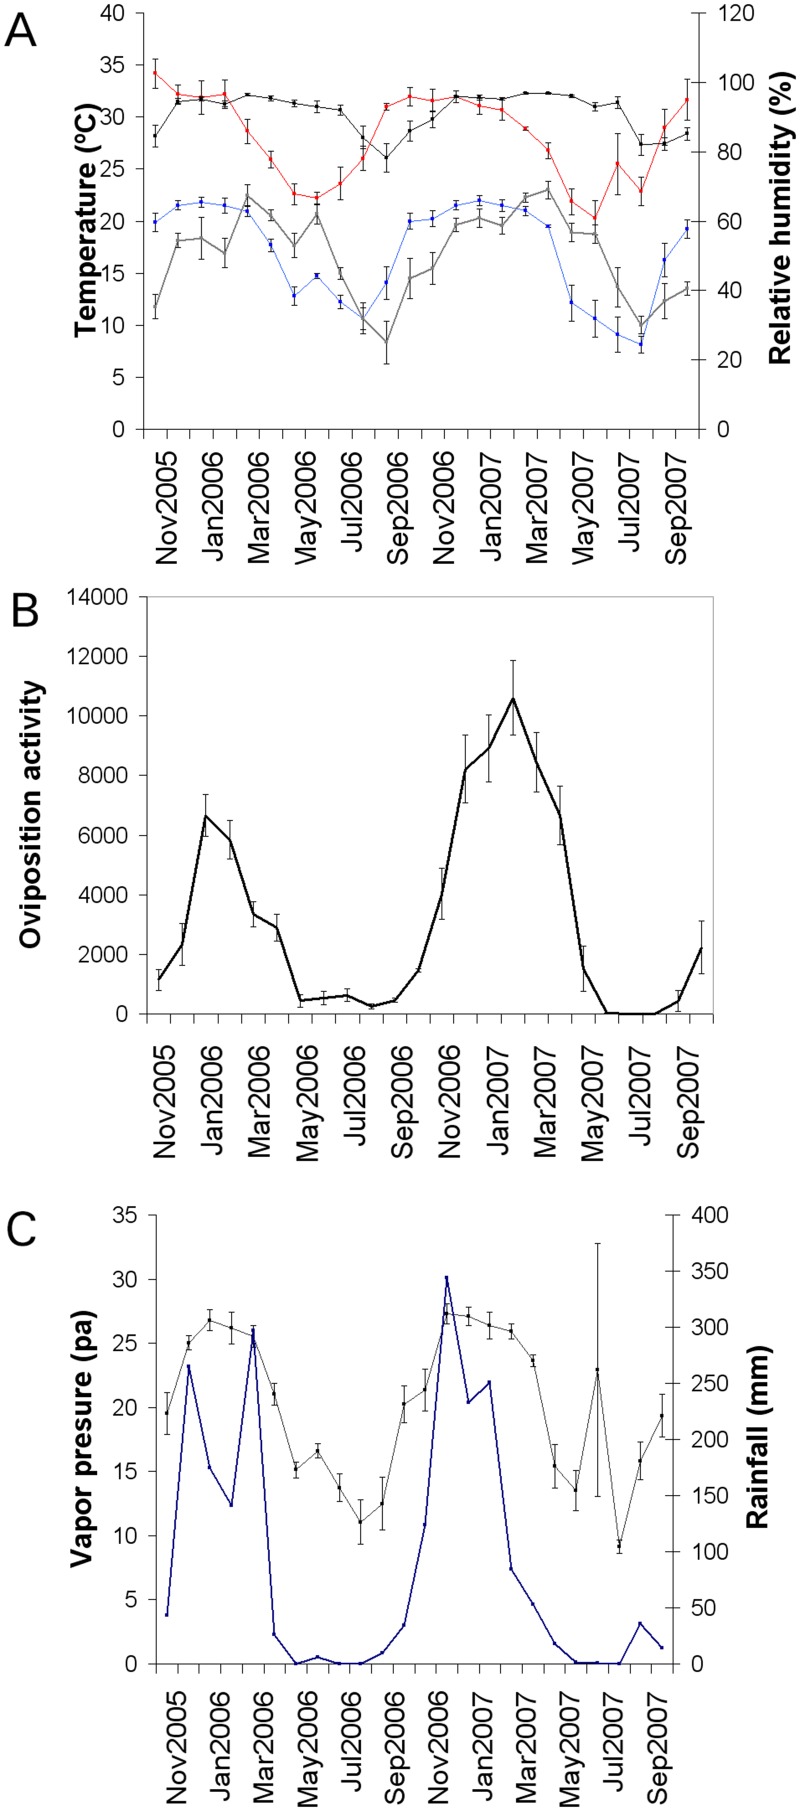
Monthly average meteorological data and oviposition activity from Orán city (November 2005 to October 2007).A: minimum temperature (blue), maximum temperature (red) and minimum and maximum relative humidity (black) (average values ±SE). B: Observed oviposition activity of Ae. aegypti. C: water vapor pressure (black) (average values ±SE) and accumulated monthly rainfall (blue).